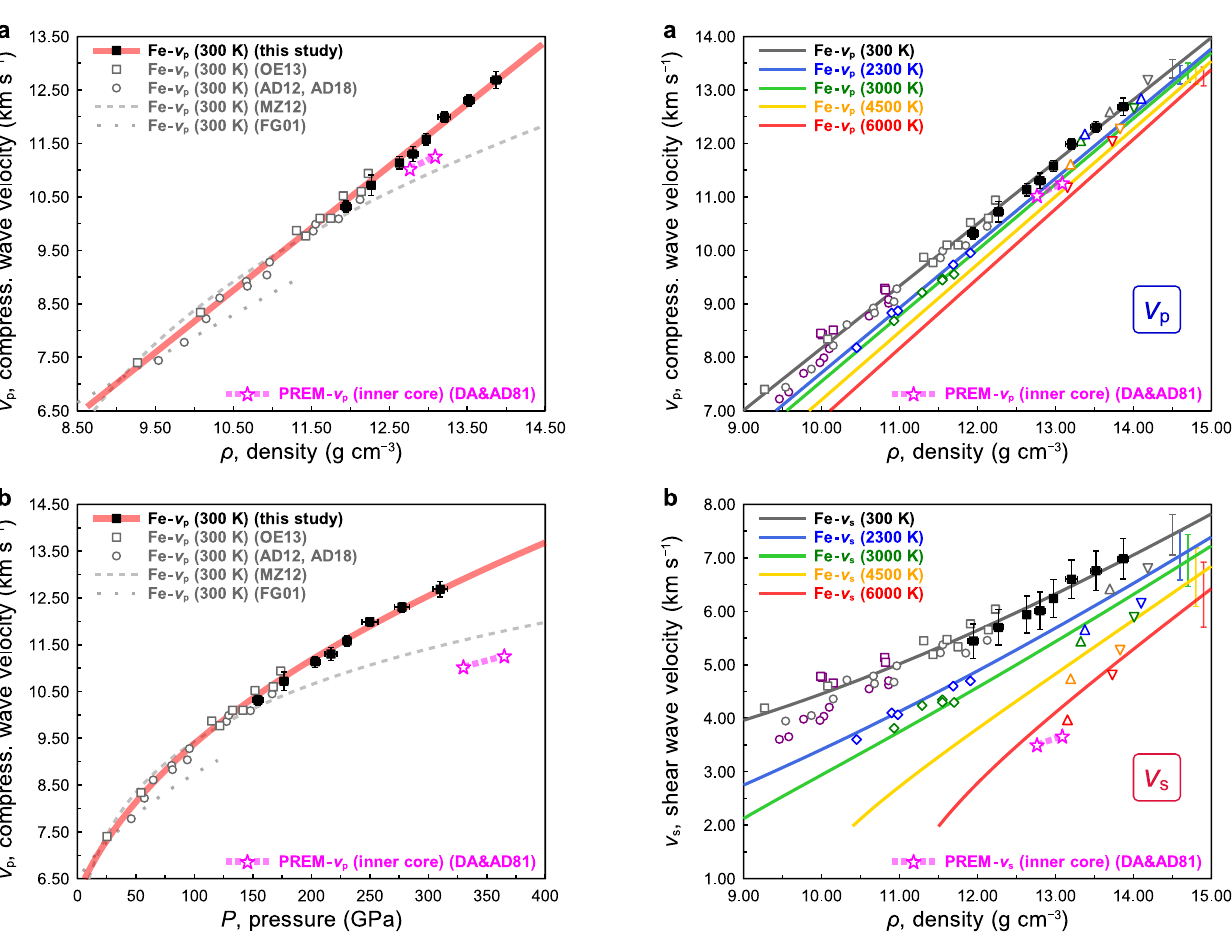
Fig. 3 | Compressional ( v p ) and shear ( v s ) wave velocities of hexagonal close- packed (iron) athigh pressure and temperature.a The v p ‒ ρ relation, i.e., Birch ’ s law 2 , for hcp-iron at different temperature. We include the ambient temperature data of this work (black solid squares) and Ohtani et al. (grey open squares) 8 , Antonangeli et al. (grey circles) 6,10 , and high temperature data by Sakamaki et al. (blue diamonds: 2300K, green diamonds: 3000K) 16 , Ohtani et al. (purple squares: 400 ‒ 1000K) 8 and Antonangeli et al. (purple circles: 700 ‒ 1110K) 6 for deriving the temperaturedependence.The theoreticaldata(colouredopentriangles, grey:0K, blue: 2300K, green 3000K, orange: 4500K, and red: 5500K) 17,18 and the Pre- liminary reference Earth model (PREM) inner core (a magenta curve with stars, DA&AD81) 1 are shown for comparison. Coloured lines represent the v p ‒ ρ relations derived from the experimental data of this work with other inelastic X-ray scat- tering (IXS) experimental data 6,8,10,16 (grey: 300K, blue: 2300K, green 3000K, orange: 4500K, and red: 6000K). b The v s ‒ ρ relation at different temperatures. The calculation of the v s for the IXS experiments are given in the Methods. The curves showing the v s – ρ relations are derived from the linear v p ‒ ρ relations in Fig.3aandtheequationofstate 3 .Symbolsgiveninthis fi gurearethesameasthose of Fig. 3a. The error bars represent 1 σ uncertainties.